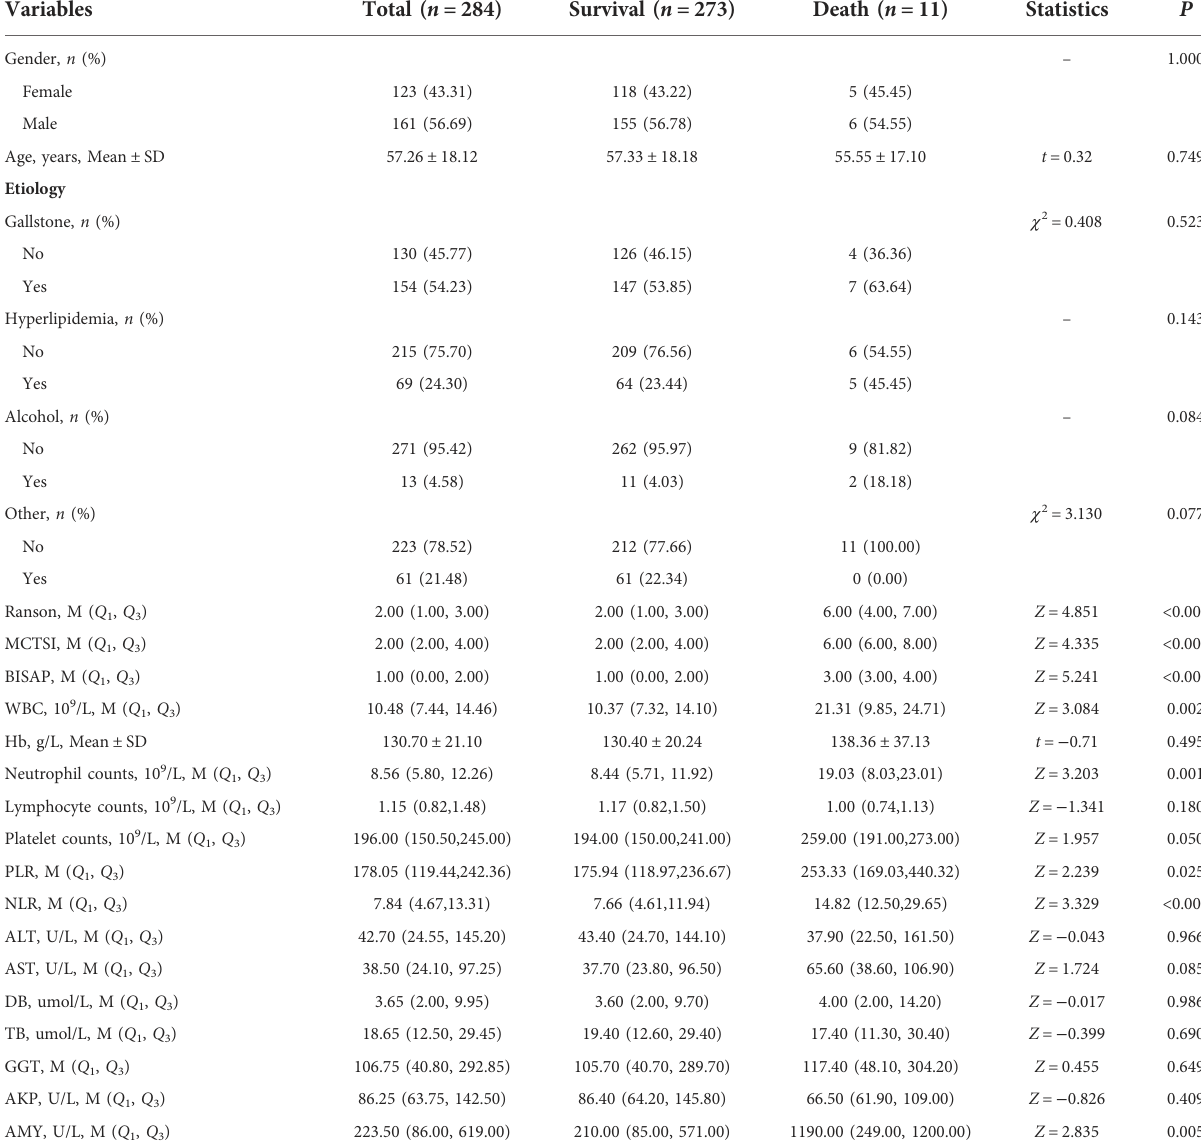
TABLE 2 Differences of population characteristics between death and survival of AP